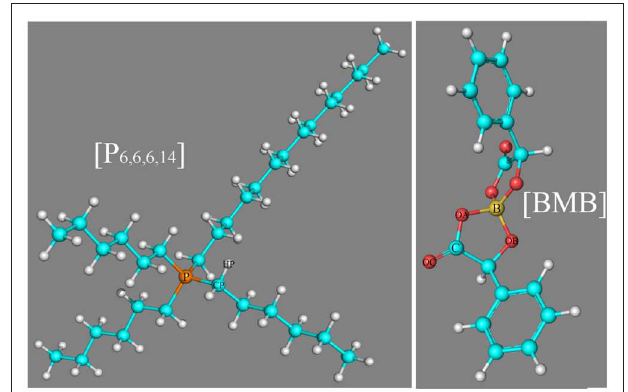
FIGURE 1 | Molecular structures of the [P 6,6,6,14 ] cation and B(S)-Man(SR) [BMB] conformer, as well as representative atom types in these two ion